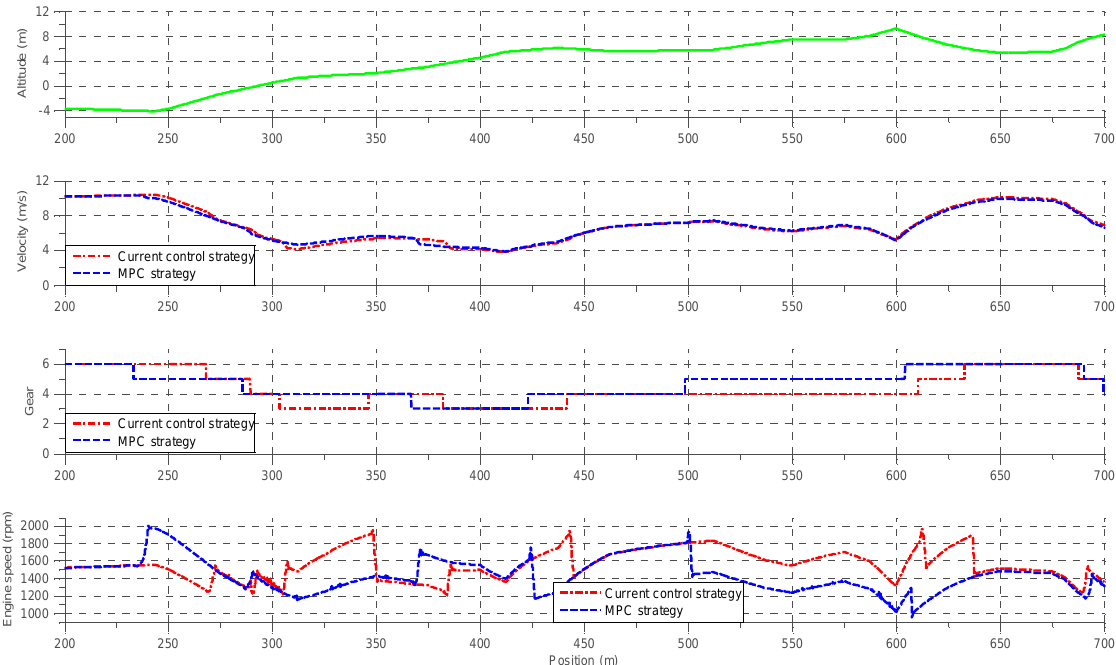
Figure 7. Simulation result with shorter prediction and control horizon. The MPC controller gives a fuel reduction of 3.11% and a decrease in trip time of